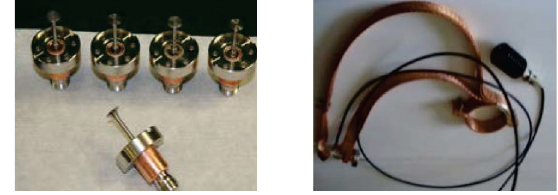
FIG. 5. New feedthroughs (left), copper braids (right) with feedthrough, cable and 50 Ω load.